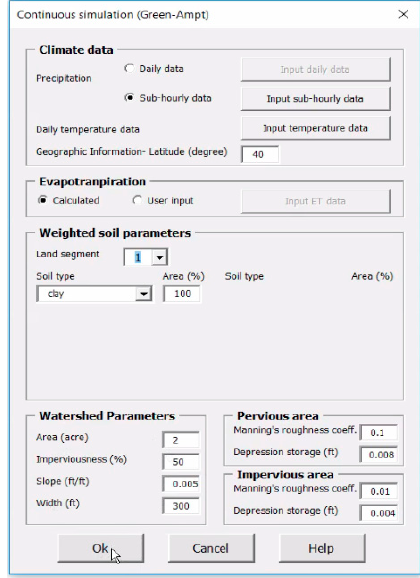
Figure A7. Defining soil type and watershed parameters